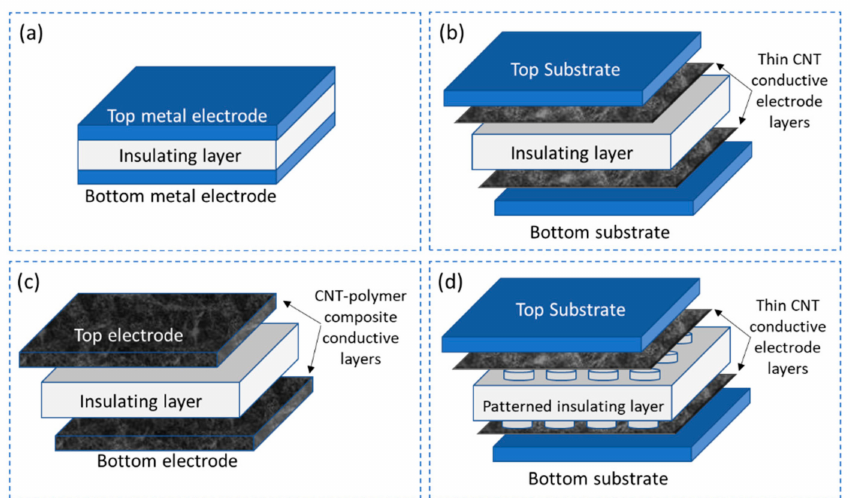
Figure 7. The parallel plate capacitive pressure sensor with insulation dielectric layer can be catego- rized in certain forms ( a ) generic form with metallic electrodes, ( b ) thin CNT layers deposited on the substrate acting as electrodes, ( c ) CNT-polymer composite based conductive electrode layers and ( d ) patterning the insulating layer to enhance the